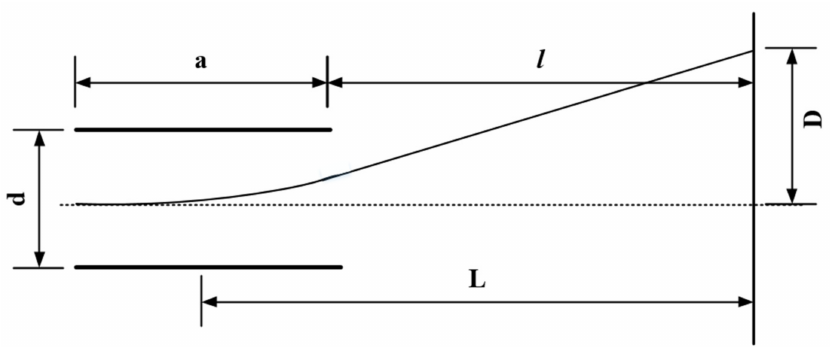
Figure 2. Structure of plate deflection plate: d is the plate spacing, a is the length of the plate, and L is the distance from the centre of the deflection electrode to the fluorescent